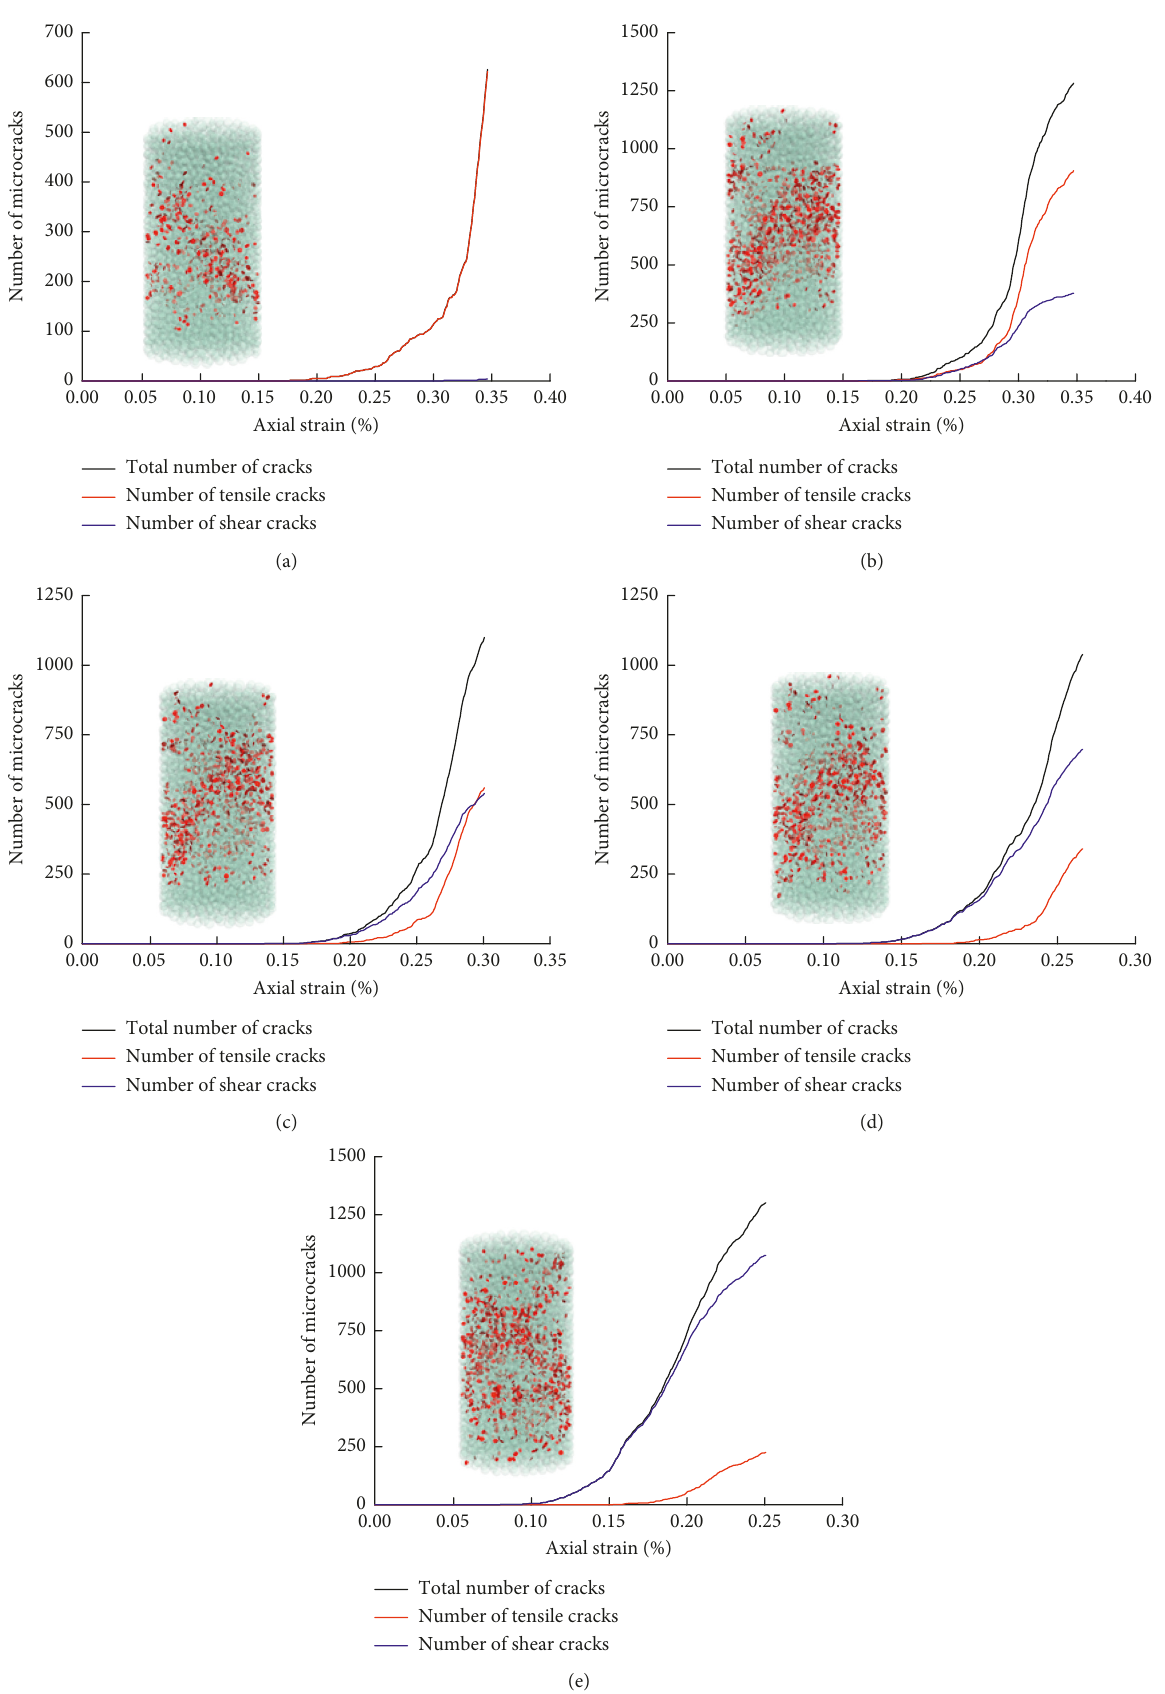
c : (a) 0.5, (b) 1.0, (c) 1.2, (d) 1.5, and (e) c /